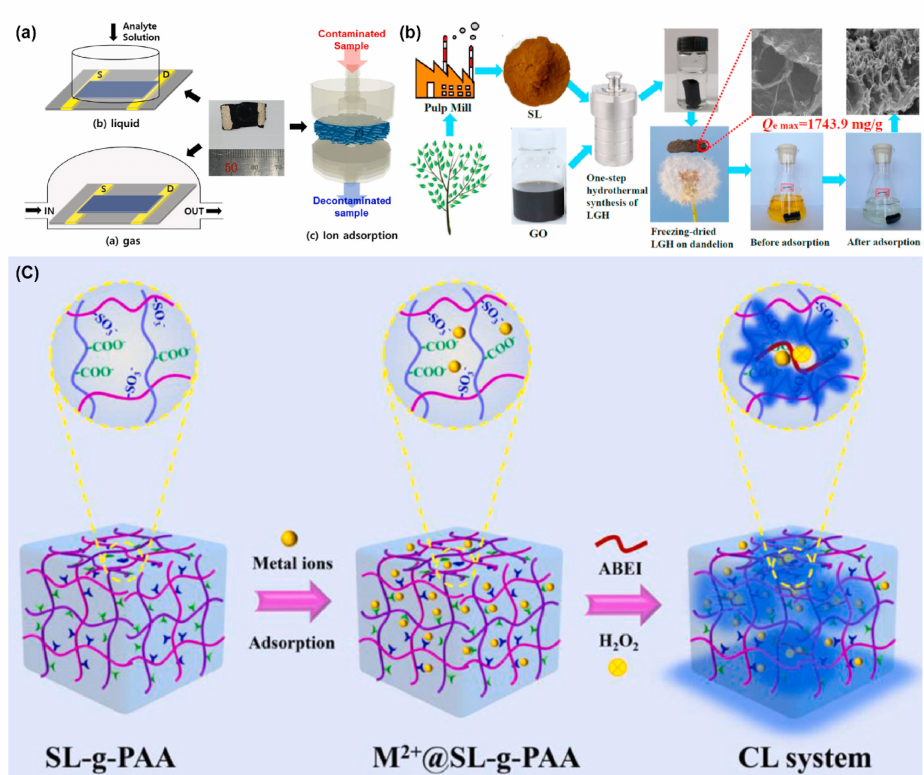
Figure 7. ( a ) Schematic illustration of the preparation of polypyrrole@lignin composites and their ap- plications in electrical sensing and metal ion adsorption. Reproduced with permission from ref. [87]. Copyright 2022, Elsevier. ( b ) Schematic illustration of the synthesis of a novel lignosulfonate-modified graphene hydrogel and its ultra-high adsorption capacity for Cr (VI) in wastewater. Reproduced with permission from ref. [89]. Copyright 2021, Elsevier. ( c ) Schematic illustration of sequential appli- cation of lignin-based composite hydrogels for heavy metal ion adsorption and chemiluminescence. Reproduced with permission from ref. [90]. Copyright 2022,